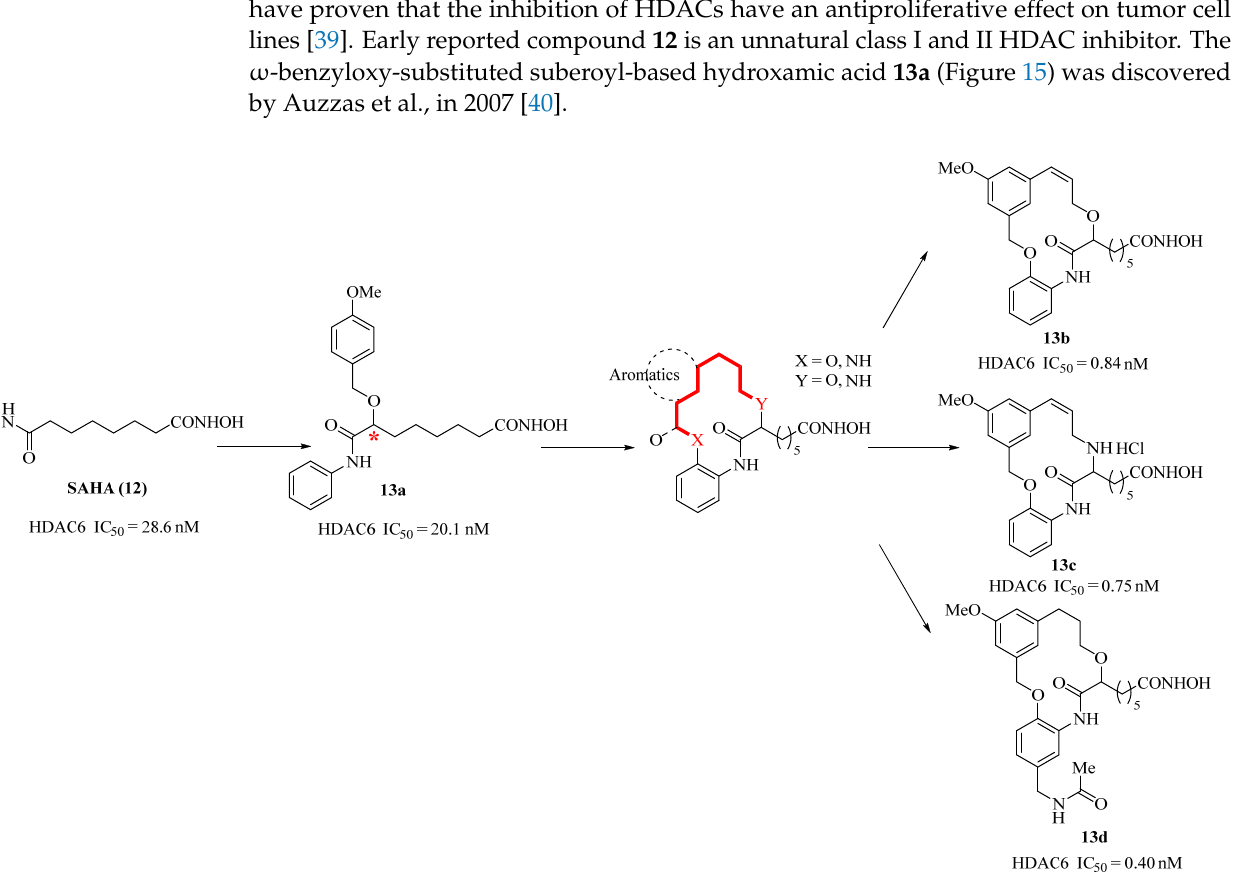
Figure 15. Structural modification of macrocyclic HDACs inhibitors.